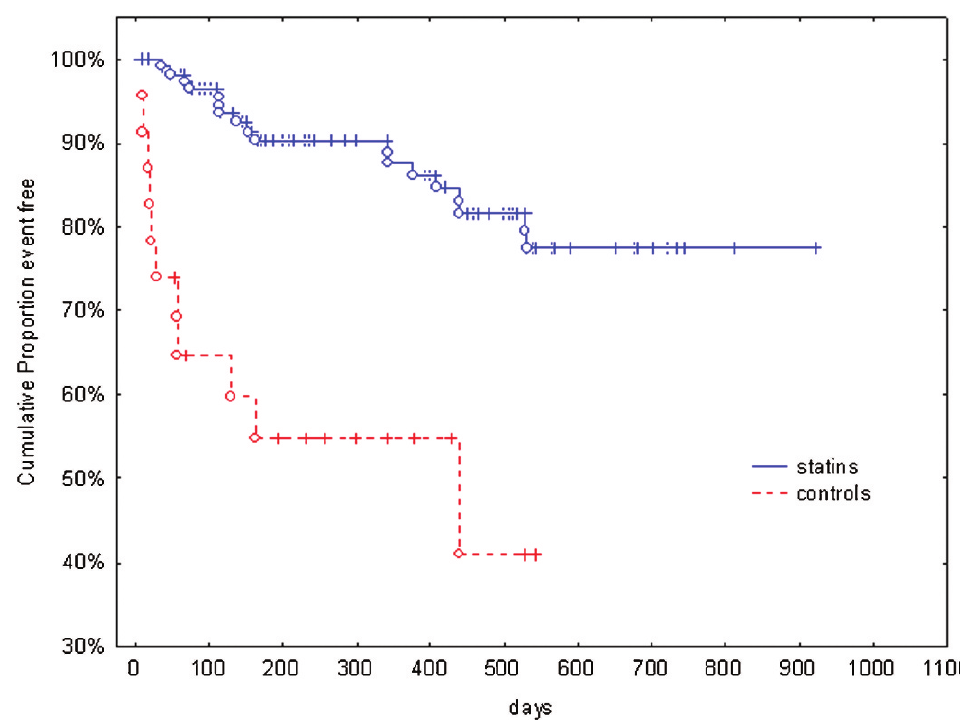
Figure 2 - Kaplan-Meier analysis showing a poorer prognosis (lower rates of readmission for decompensated heart failure) in subjects not receiving therapy with statins (log-rank p ,